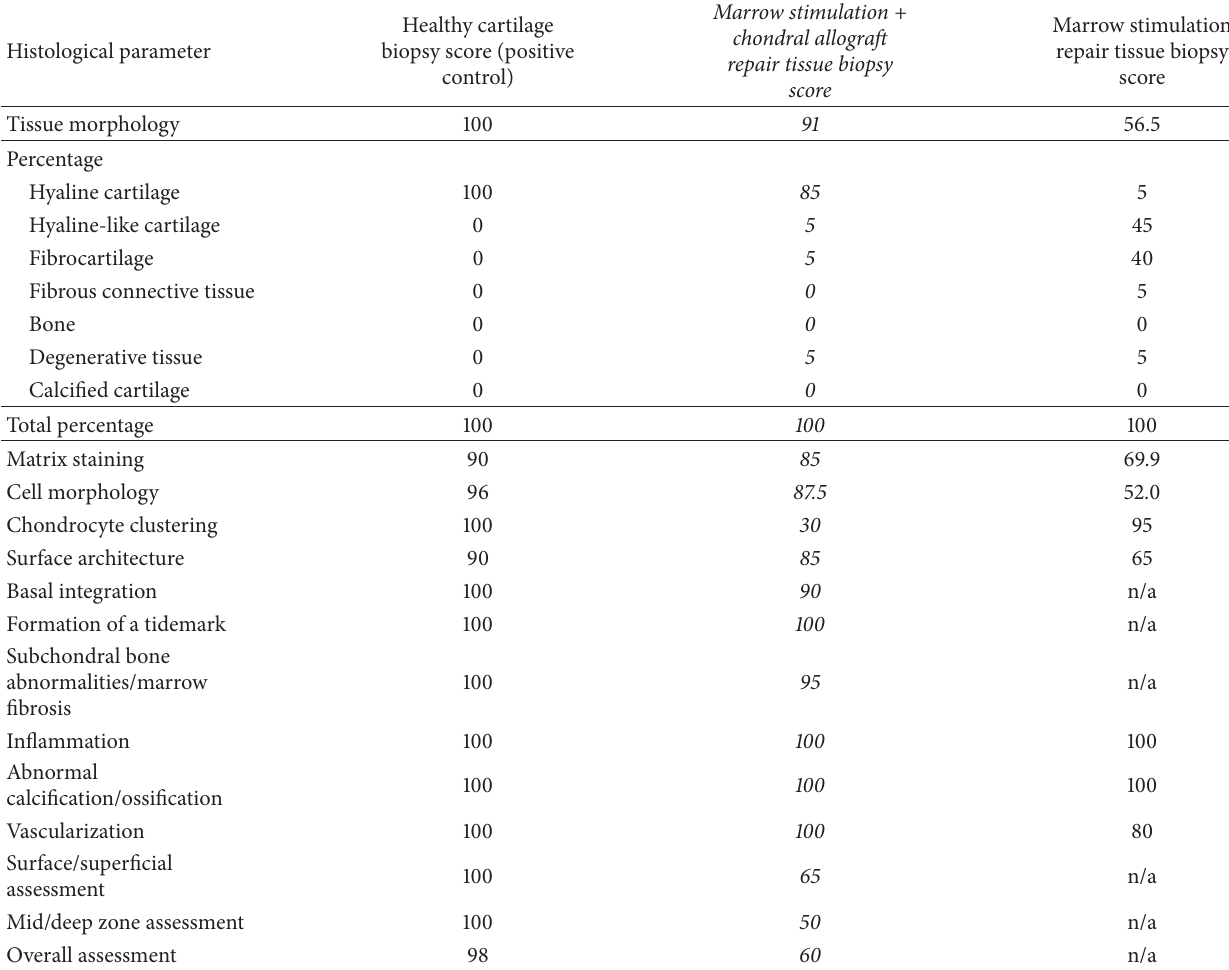
Table 1: Summary of histological findings. ICRS II scores for patient repair tissue (italic) as well as healthy cartilage and marrow stimulation repair tissue for comparison. Some parameters could not be scored for the marrow stimulation repair tissue due to the loss of tissue architecture upon